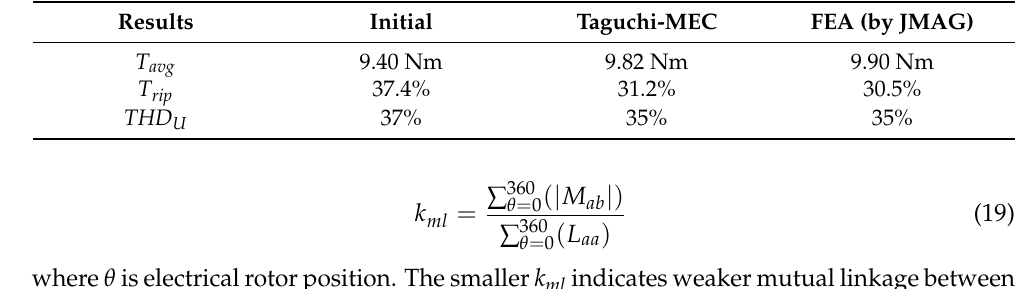
Table 6. Comparison of the Optimization Results Between Taguchi-MEC and FEA.